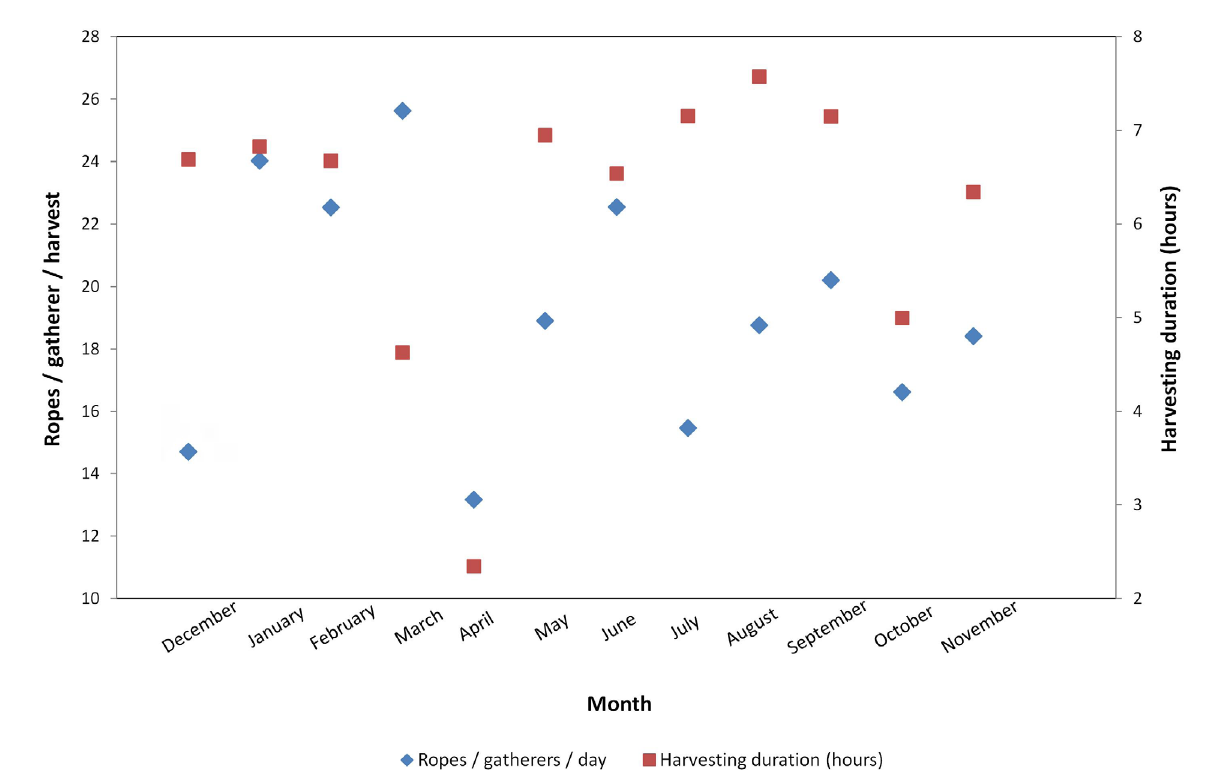
Figure 2. Monthly values for CPUE and duration of harvesting (hours) of Ucides cordatus in the Parnaíba River Delta, Brazil,